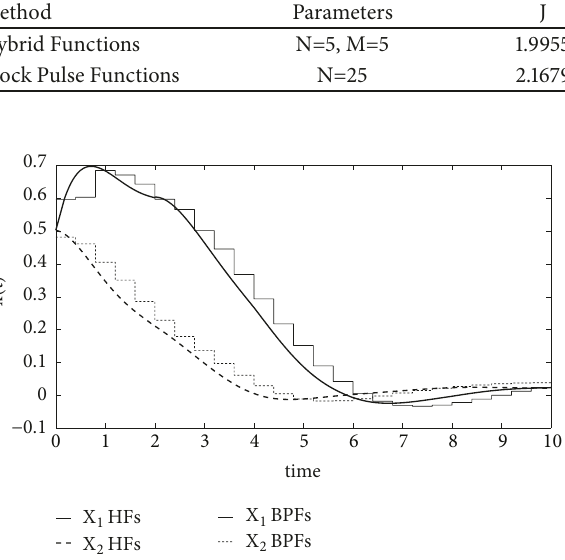
Figure 1: Optimal states trajectories with hybrid functions (HFs) and block pulse functions